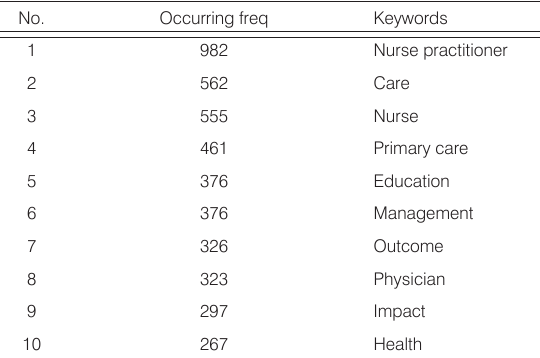
Figure 5. Knowledge map of keywords related to Nurse Practitioners. (2007-2018).